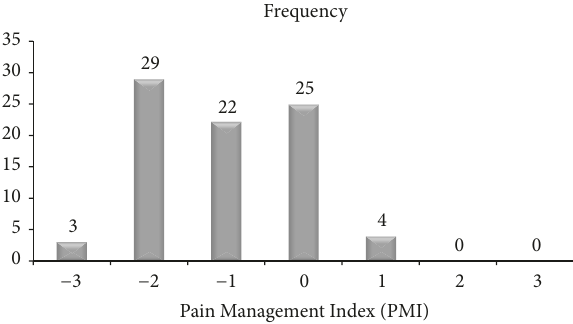
Figure 2: Pain Management Index in cancer patients, Gondar University Hospital, Gondar,